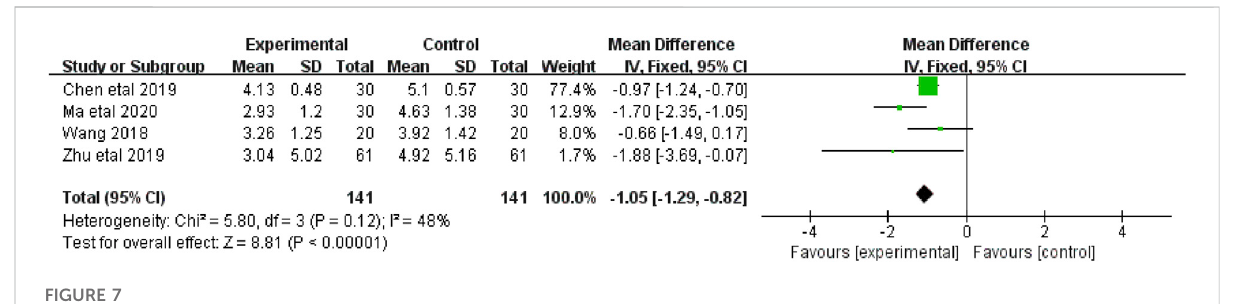
FIGURE 7 The forest plot of behavioral subscales of PFS